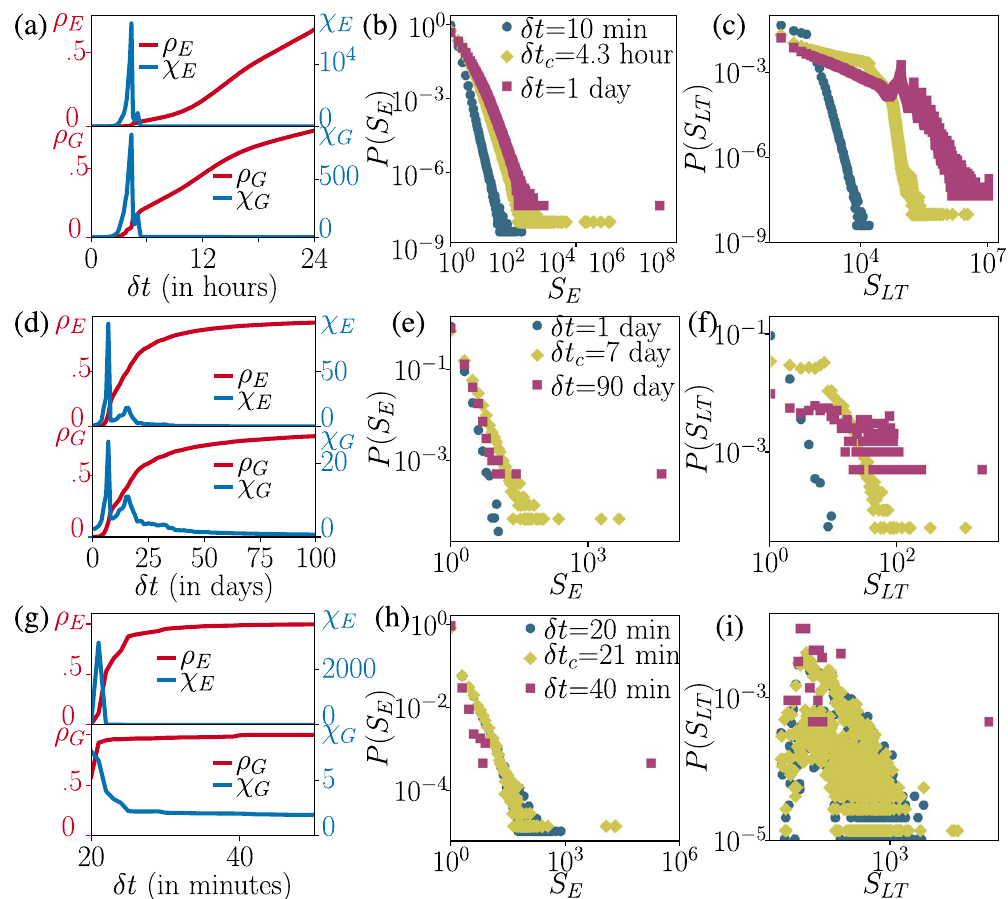
Figure 3. Percolation transitions in empirical temporal networks of mobile communication ( a – c ), sexual interactions ( c – e ), and air transportation ( g – i ). Panels (a,d,g) depict the order parameter ρ and susceptibility χ ( δ t ) (solid blue lines) of weakly connected components with sizes in events (upper panels) and temporal-network nodes (lower panels). Panels (b,e,h) show the size distributions of weakly connected components in the event graph measured below (blue circles), at (yellow diamonds), and above (violet squares) the critical δ t c . ( c , f , i ) are the same but depict the distribution of the lifetimes of weakly connected components in D